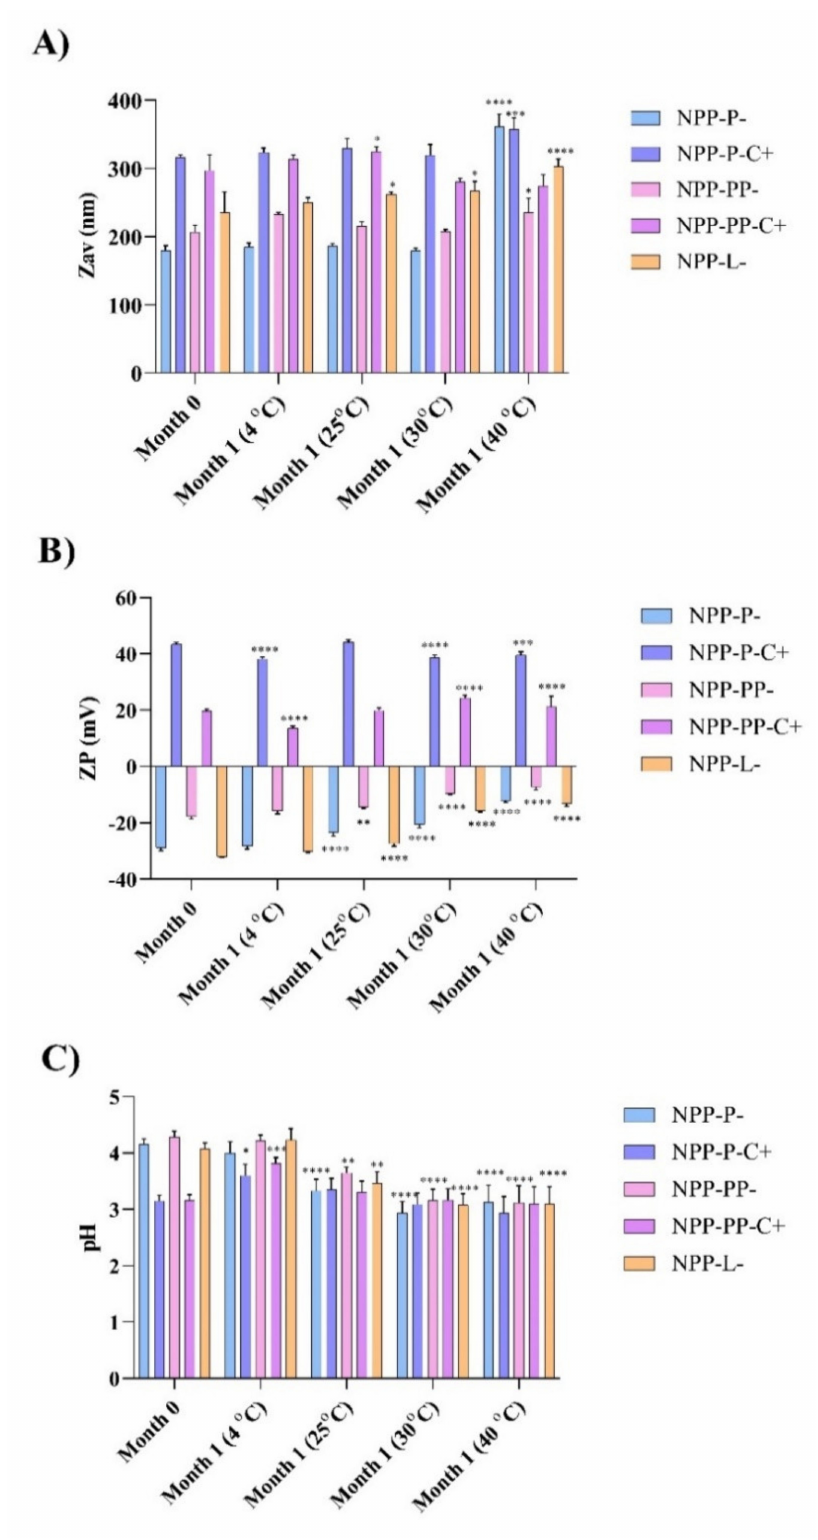
Figure 1. One-month stability of TH NPs with different surface functionalization strategies at 4, 25, 30 and 40 ◦ C. ( A ) Average size, ( B ) Zeta potential (ZP), ( C ) pH values. Statistical significance was analyzed against freshly prepared formulations (one month), * p < 0.5; ** p < 0.01; *** p < 0.001; **** p <